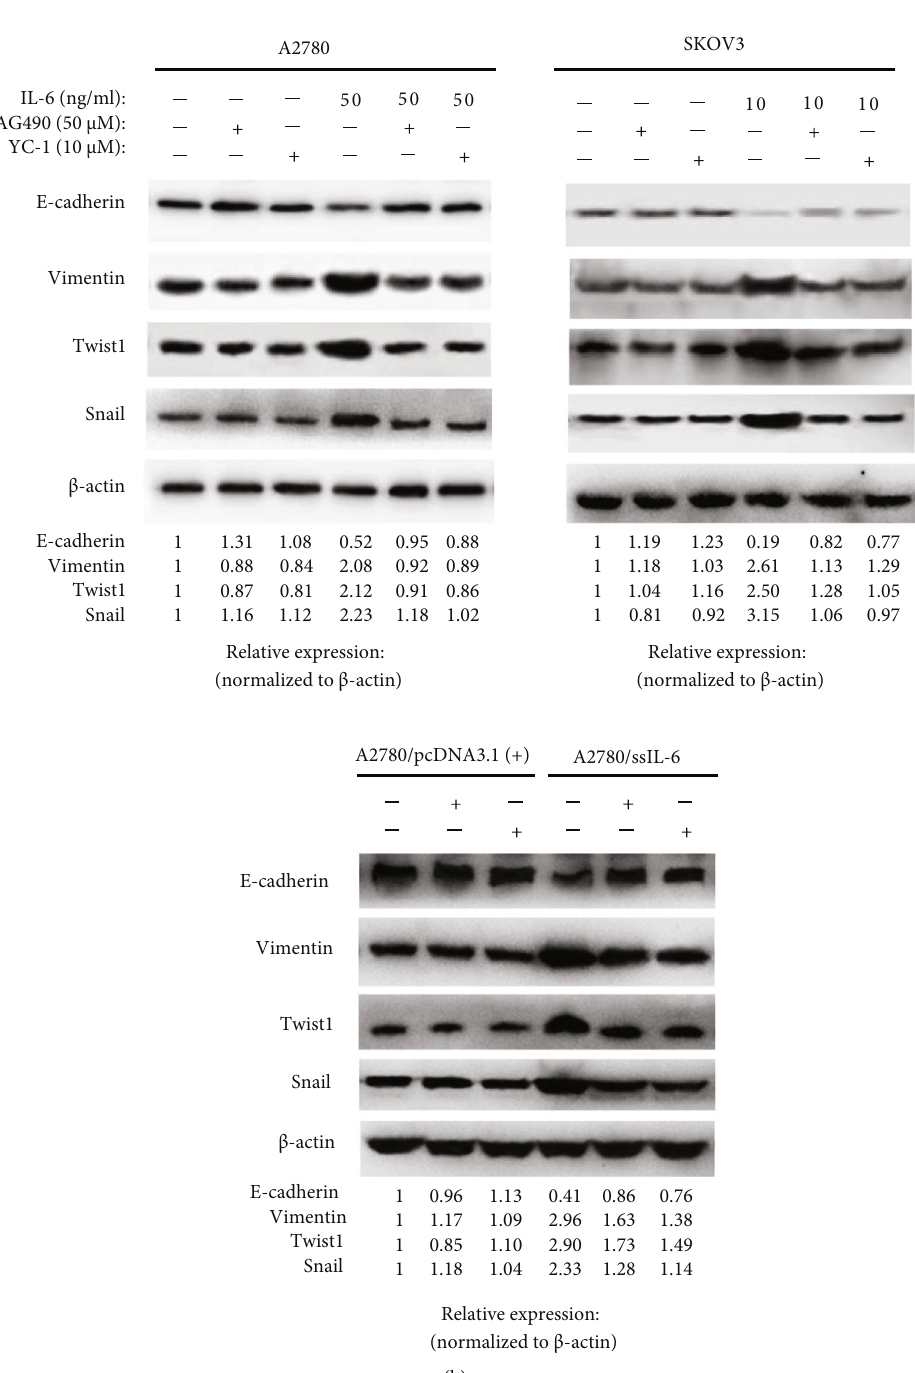
Figure 5: The IL-6/STAT3/HIF-1 α loop mediates IL-6-induction EMT in EOC. (a) Correlation between the generic EMT score and gene expression of each molecule in the signaling loop. Scatter plots showed EMT signature scores and normalized mRNA levels of 489 EOC samples based on TCGA dataset. Spearman ’ s rank correlation analysis. (b) Blocking STAT3 and HIF-1 α with corresponding inhibitors (AG490 inhibits STAT3 and YC-1 inhibits HIF-1 α ) reversed IL-6-induced EMT in A2780, SKOV3, and A2780 clones overexpressing IL- 6. Protein levels displayed are representative of three independent experiments with similar